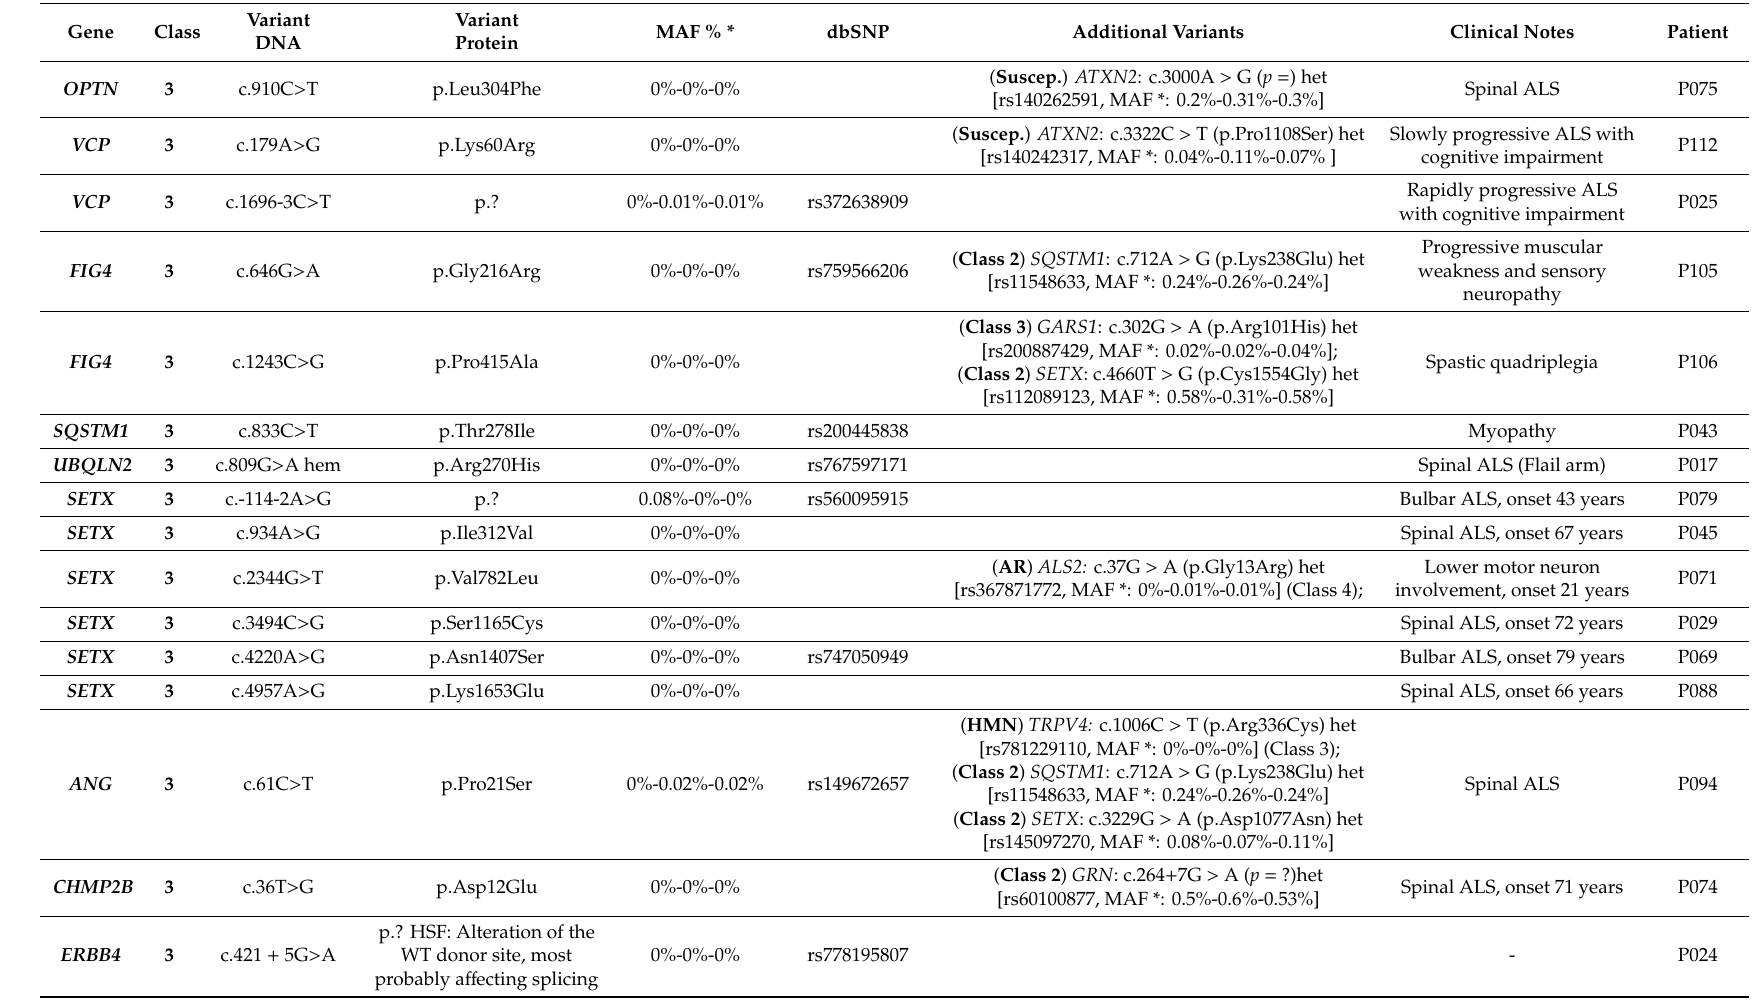
Table 5. Variants of unknown significance (VUS) in ALS / HMN / FTD genes (Class